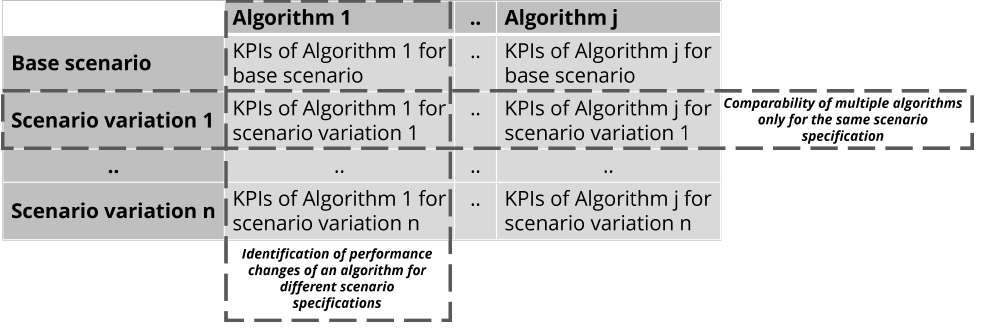
Figure 3. Two different scopes and the according ways to evaluate the results of concrete scenario